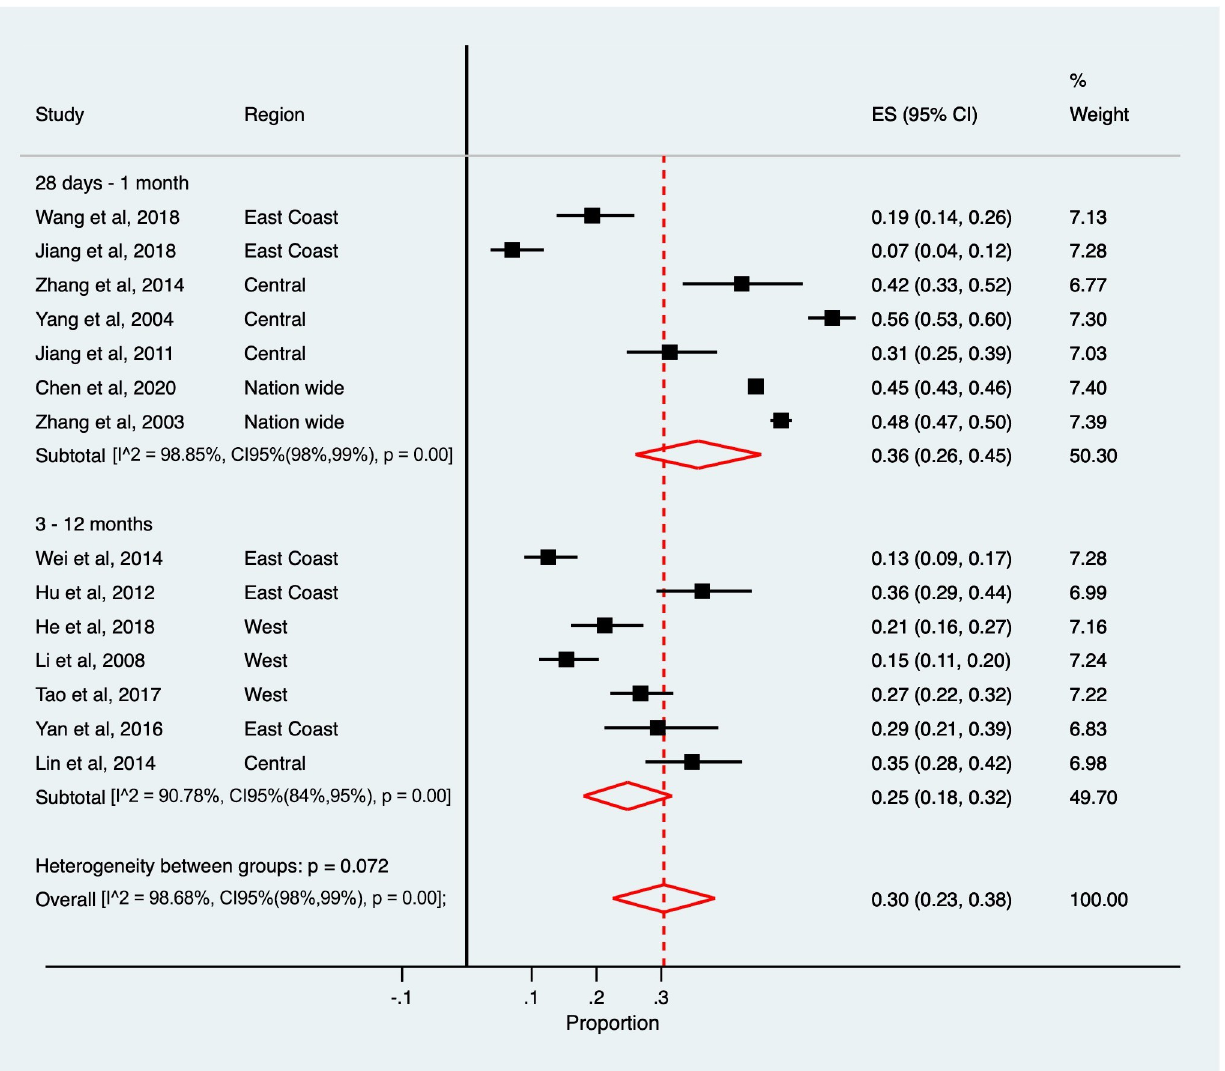
Fig 5. Pooled case-fatalities of haemorrhagic